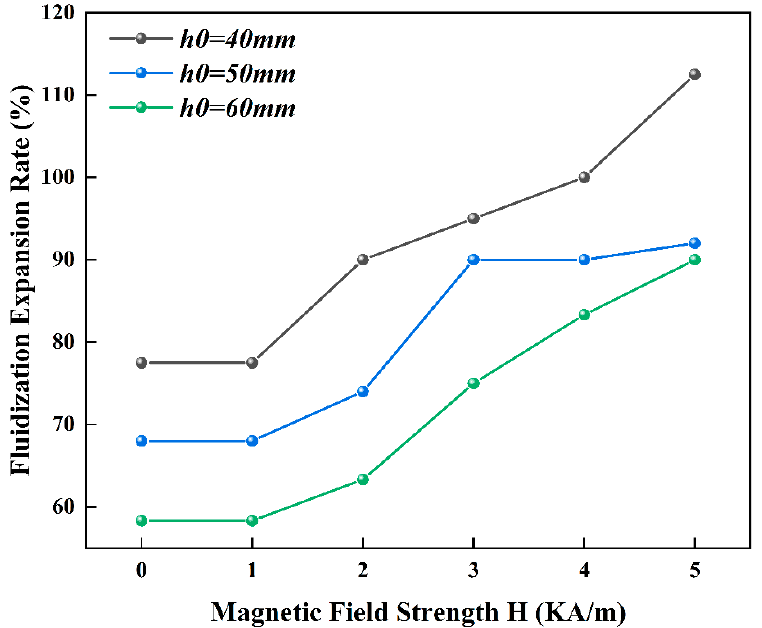
Figure 10. Stable fluidization expansion rate of the bed under different static bed heights.